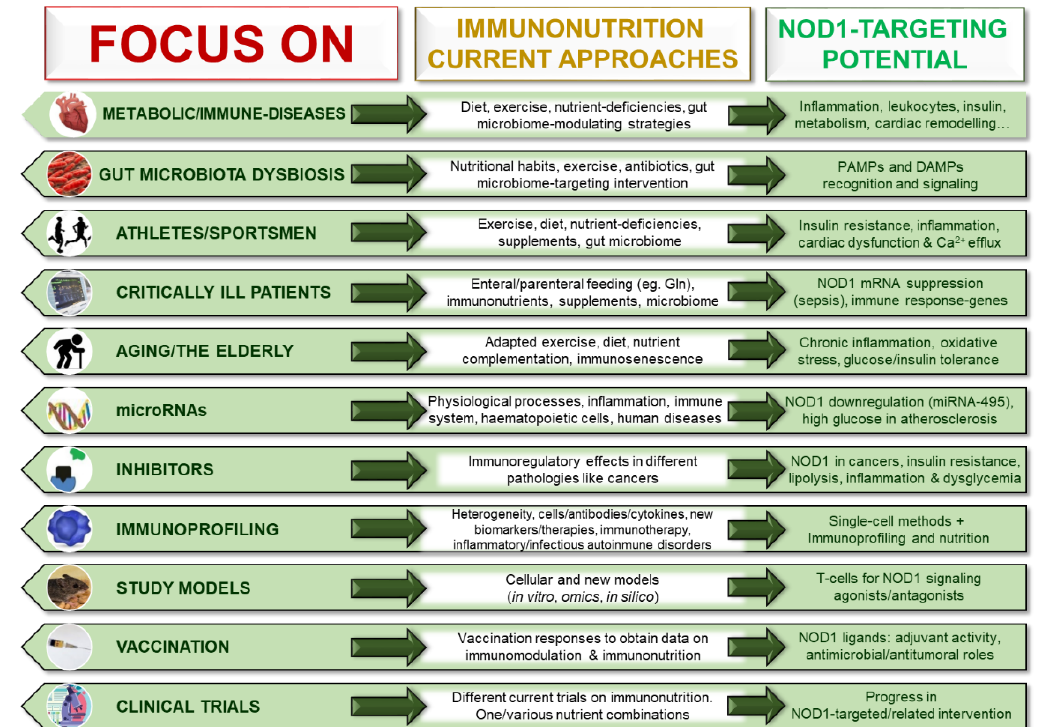
Figure 4. Looking to the future: promising novel NOD1–immunonutrition perspectives. Integrated, interdisciplinary, and personalized strategies are considered the future in the fight against today’s global diseases. This figure collects different fields related to existing immunonutrition strategies and that could exploit the potential of a dual approach with interventions targeting NOD1. Metabolic and immunological disorders (such as obesity or diabetes), content and function of the intestinal microbiota, athletes or professional athletes (suffering from respiratory diseases, infections or gastrointestinal disorders), critically ill patients, the elderly, mechanisms of aging/senescence, microRNAs, inhibitors immune system and immune checkpoint inhibitors, immunoprofiling, biological or nonbiological study models (highlighting cell and animal models), vaccination flow diagram and ongoing clinical trials on immunonutrition (using various combinations of immunonutrients) are discussed here. NOD1 has almost undiscovered potential as a therapeutic target that should be used against human disorders. New treatments can complement or improve existing therapeutic and nutritional